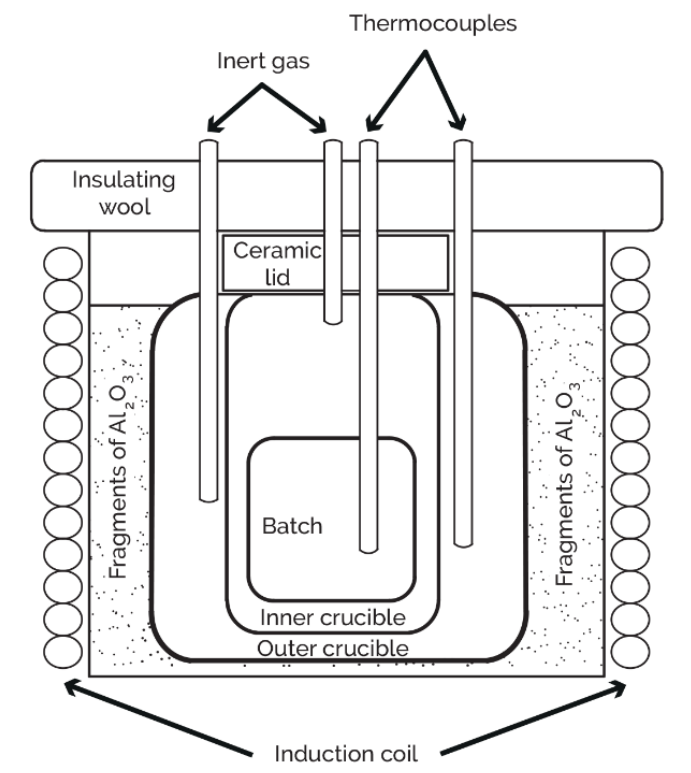
A FeO-TiO 2 -Ti 2 O 3 ternary phase diagram at 1600 °C and 1500 °C is shown in Figures 2 and 3, respectively, which were prepared with FactSage version 6.4 using FactPS and FToxid databases. Figure 1. Schematic diagram of the induction furnace used for the preparation of the slags. The synthetic samples were made from mixtures of TiO 2 (>99.5 pct), Ti 2 O 3 (>99.9 pct), FeO (>99.5 pct), MgO (>99.9 pct), MnO (>99.9 pct), SiO 2 (>99.9 pct), and Al 2 O 3 (>99.5 pct). The concentration of components used for each test is described in Table 1. The percentage composition of TiO 2 and Ti 2 O 3 selected for each test was comparable to the actual indus- trial slag. The presence of FeO can play an important role in the slag formation, so a wide range (1% to 15%) of composition was selected. The MgO composition in industrial slag is around 1–2%, but there can be an increase in composition because the ilmenite smelter operates with a freeze lining of a solidified slag against the furnace wall [15]. Any damage caused to the freeze lining may result in a higher concentration of MgO in the slag. To accommodate this variation, the percentage composition of MgO was from 0.6% to 10%. All the other impurities were within the range of industrial slags.